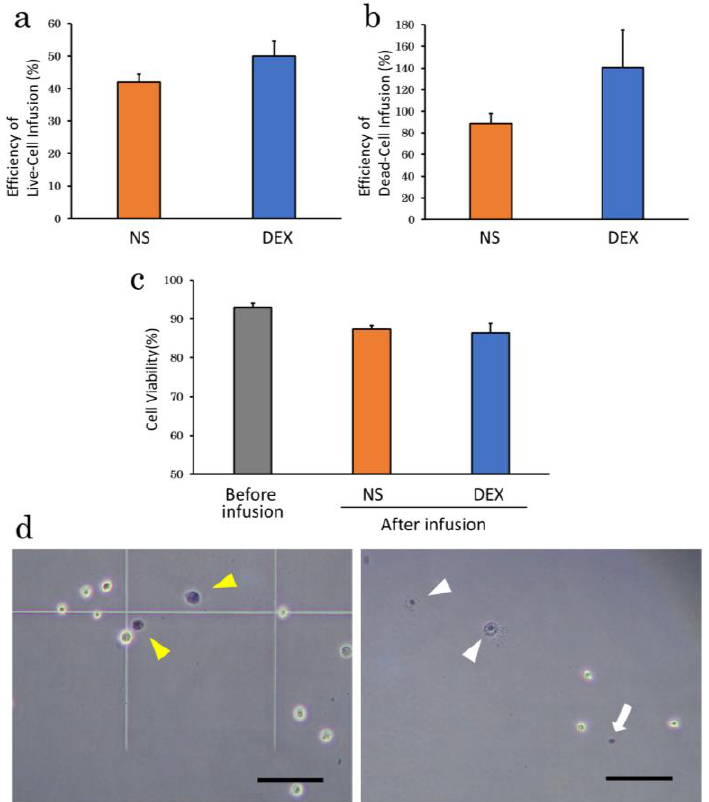
Figure 3. Efficiency of cell infusion and cell viability in different suspension solutions. ( a ), Efficiency of live-cell infusion for NS and DEX. There were no significant differences, but efficiency of live-cell infusion tended to be higher in DEX; ( b ), Efficiency of dead-cell infusion for NS and DEX. Efficiency of dead-cell infusion also tended to be higher in DEX; ( c ), Cell viability after infusion for NS and DEX showed a slightly lower in DEX; ( d ), Microscope images of dead cADSC suspended in NS ( left panel) or DEX ( right panel). Trypan blue-stained dead cells suspended in NS were comparable in size and morphology to live cells ( left panel; yellow arrowheads). Small concentrated Trypan Blue-stained dead cells ( right panel; white arrows) and cells that appeared to be bursting ( right panel; white arrowheads) were observed in DEX. NS: normal saline; DEX: 5% dextrose. Bar = 100 µ